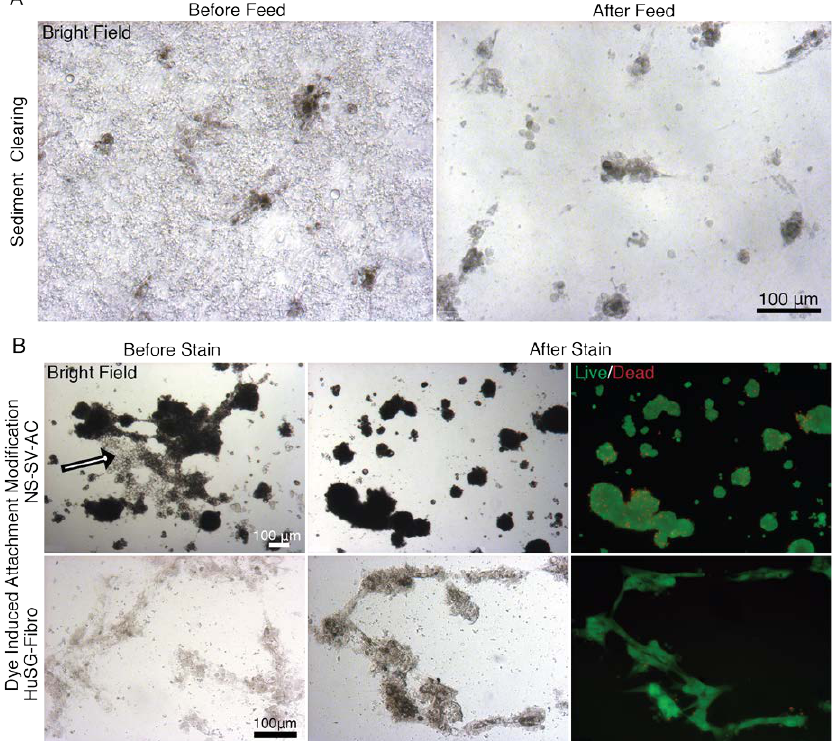
Figure A9. Images of NS-SV-AC and HuSG-Fibro cells in EYP Cocktails Captured in Bright Field and Fluorescent Microscopy Before and After Injecting Live/Dead Stain. These observations don’t apply to EYP+EW. ( A ) HuSG-Fibro growing in EYP + Medium before and after feeding on the 4th day. Sedimentation varied and cleared after adding the medium/stain combination. The sediments might result from variation in pasteurization step or improper EY isolation from the EW. ( B ) The addition of the Live/Dead stain detached—within a few seconds—some of the NS-SV-AC cells that were in a sheet conformation (minority) (Arrow). This was mainly observed with the NS-SV-AC cells. Other NS-SV-AC cells already as spheres remained spheres. Images of HuSG-Fibro and NS-SV-AC cells were captured at 10 and 14 days respectively.